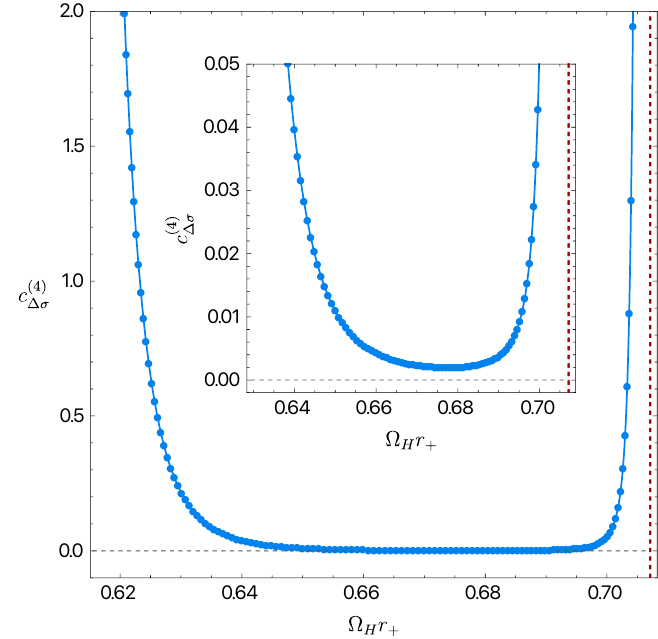
Figure 4 . Lowest-order perturbative correction to the entropy of Myers-Perry black strings by branching m = 2 black resonator strings near the onset of the superradiant instability. The horizontal axis shows the dimensionless angular velocity e Ω H of the strings. The vertical axis shows the difference (4.15) between the dimensionless entropy of the resonator and Myers-Perry black strings with the same ( L, E , J ) . Since c (4) > 0 , black resonator strings always dominate the ∆ σ microcanonical ensemble around the superradiant merger line. The divergences near endpoints imply that perturbation theory is breaking down at these locations. (See also later figure